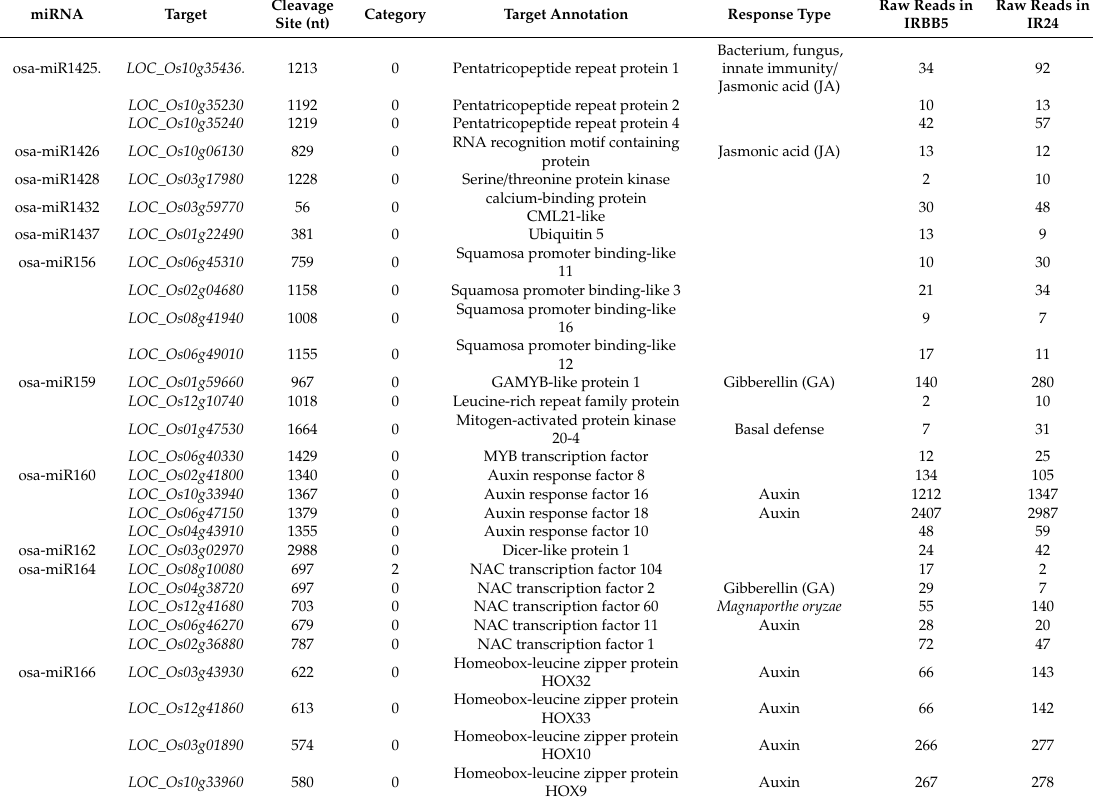
Table 1. miRNA Targets assembly with category ≤ 2 and raw reads ≥ 10 in at least one library. miRNA Target Cleavage Site (nt) Category Target Annotation Response Type Raw Reads in IRBB5 Raw Reads in IR24